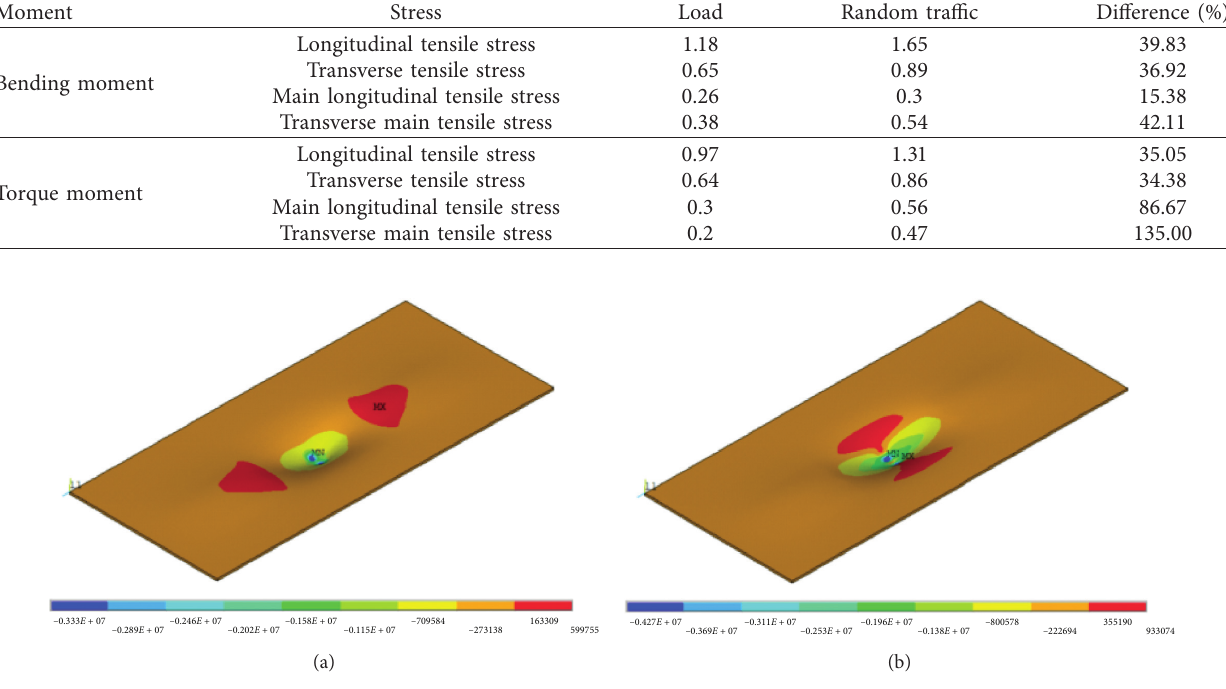
Figure 14: The stress diagram of the midspan pavement layer under dual-wheel load. (a) The longitudinal stress diagram. (b) The transverse stress